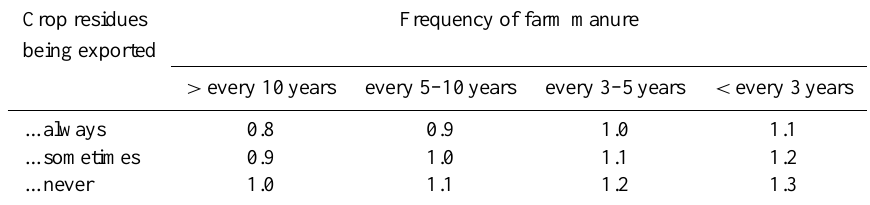
Table 1. Definition of the coefficient f s to characterize the cultivation